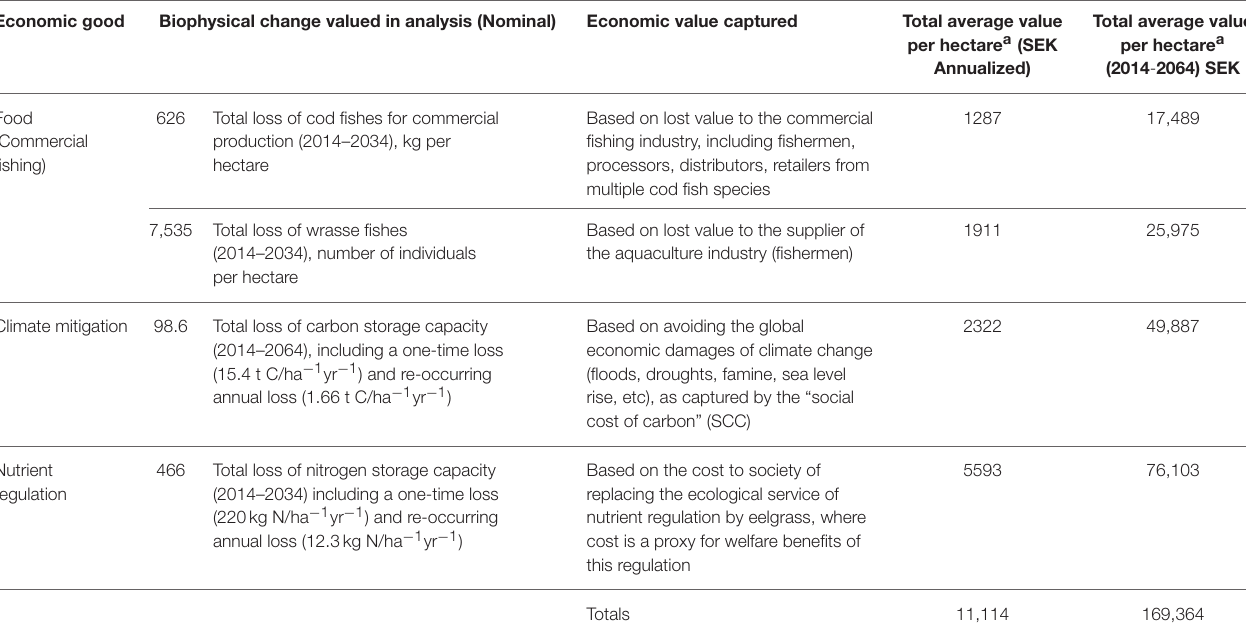
Economic good Biophysical change valued in analysis